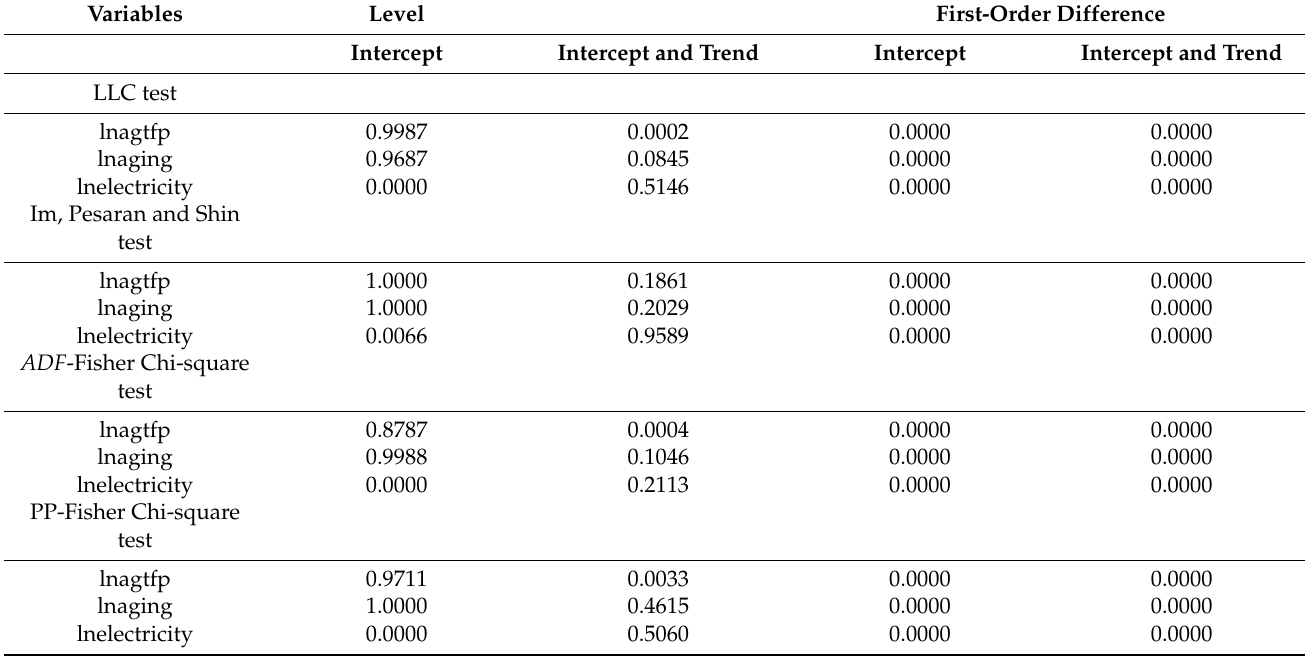
Table 2. Panel unit root test results.